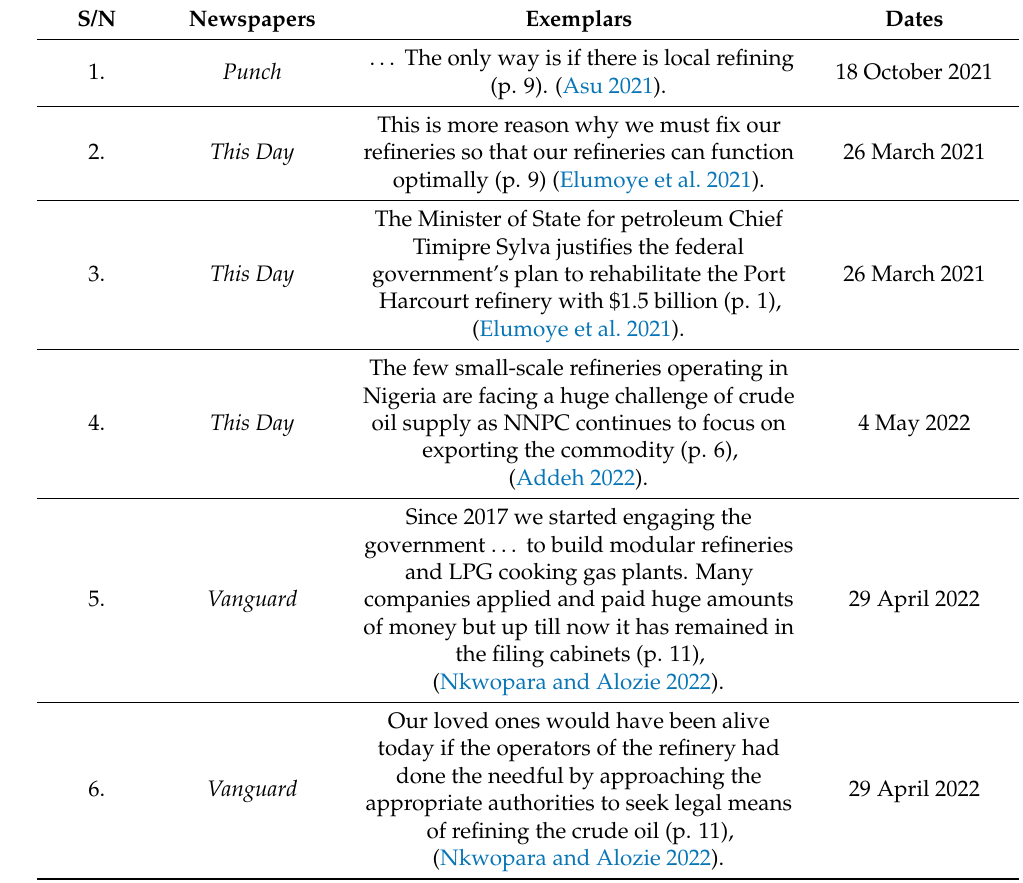
Table 3. Structural Amnesia and Modal Categorical Claim to Truth and